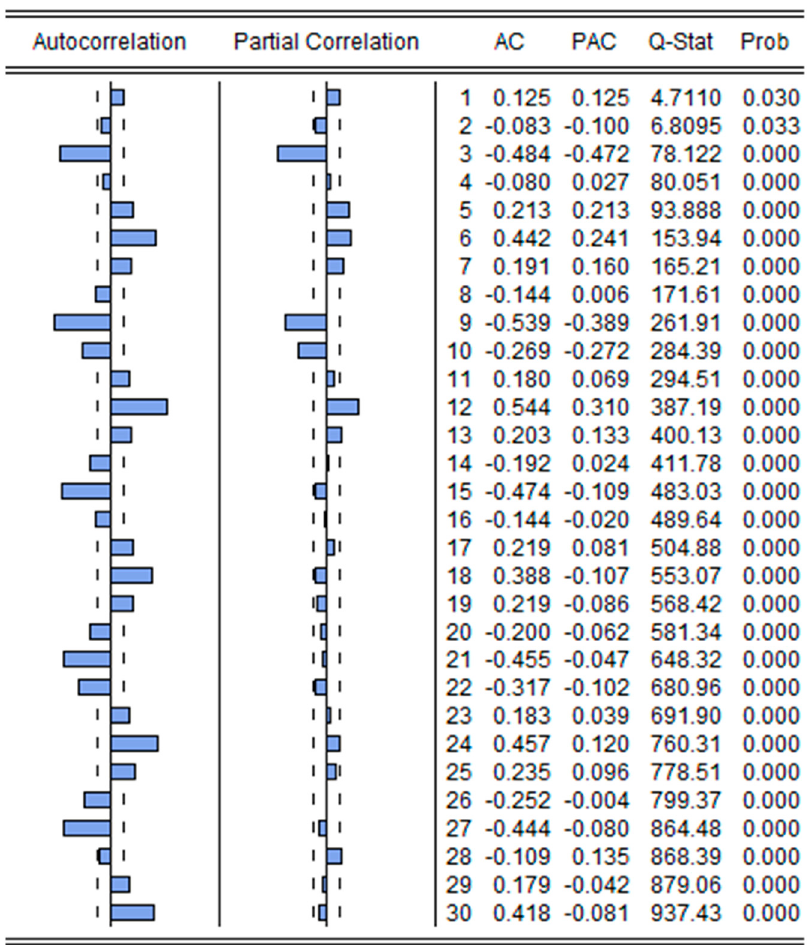
Figure 4. Residuals of designated model through plotting ACF and PACF.